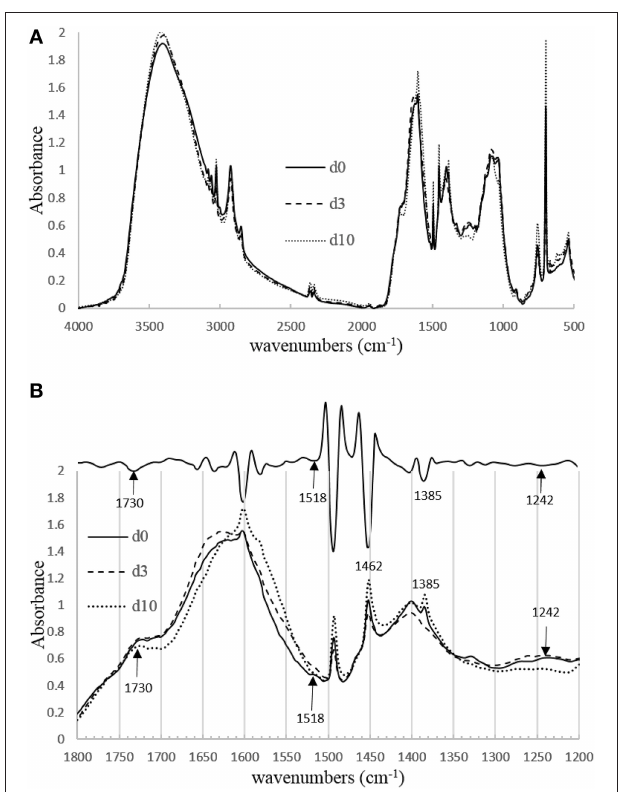
FIGURE 8 | (A) The region between 4000 and 500cm − 1 of the FT-IR spectra for the initial wood leachate sample and after 3 and 10 days of irradiation. (B) Bottom: The region between 1800 and 1200cm − 1 of the FT-IR spectra. Upper: second derivative FT-IR spectrum obtained from day 10 irradiation. compounds can produce OH radicals; these phenolic